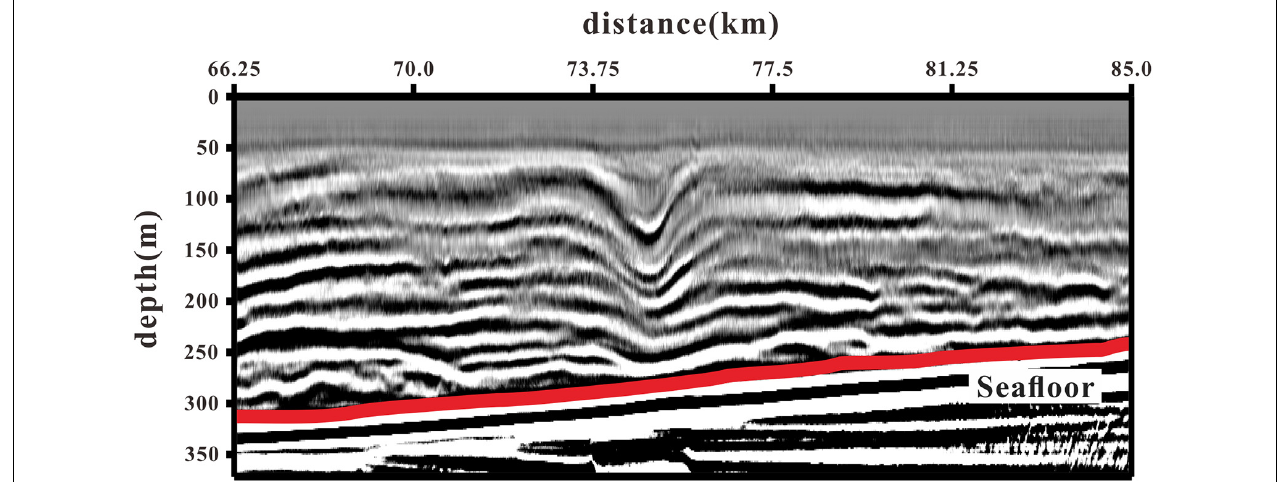
FIGURE 4 | Stacked section of the internal solitary wave. The red line represents seafloor.